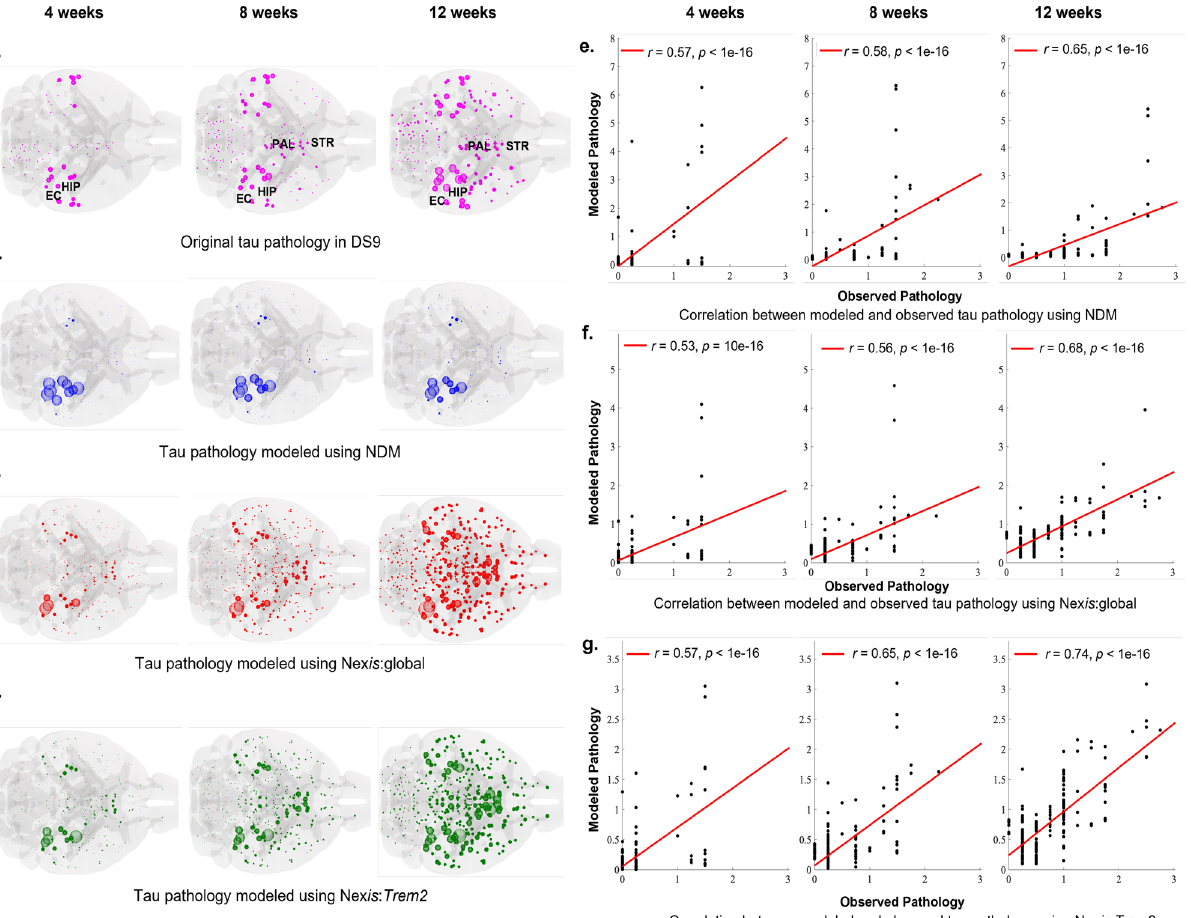
Figure 4. NDM, Nex is :global, and Nex is : Trem2 model fits for dataset DS9. Panel ( a ): Empirical tau pathology observed in DS9 post hippocampal seeding of exogenous tau 27 . Panels ( b )–( d ): NDM, Nex is :global, and Nex is : Trem2 modeled tau pathology progression, respectively, in DS9 dataset at 4, 8, and 12 weeks post hippocampal injection. Panels ( e )−( g ): Scatter-plots depicting the correlation between empirical and ND-modeled ( e ), Nex is :global-modeled ( f ), as well as Nex is : Trem2 -modeled ( g ) tau pathology, respectively, at 4, 8, and 12 weeks post hippocampal tau seeding. Pearson r values are provided for each scatter plot. HIP, hippocampal area; EC, entorhinal cortex; PAL, pallidum; STR,